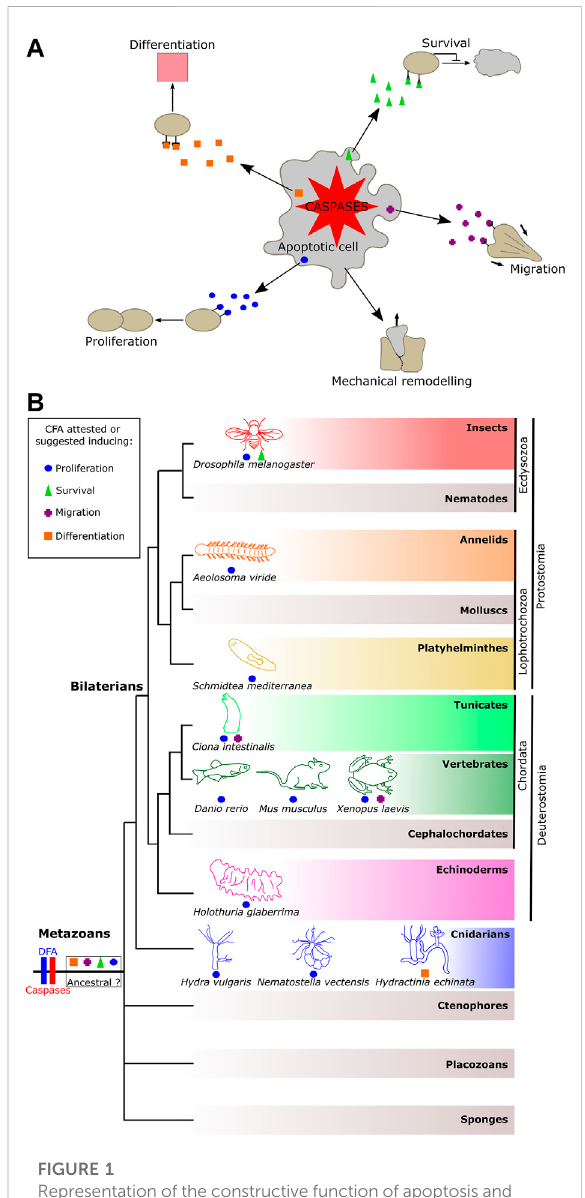
FIGURE 1 Representation of the constructive function of apoptosis and its occurrence among metazoans. (A) Constructive function of apoptosis(CFA)allowsapoptoticcellstopromotecellremodeling, fates, and behaviors to their neighbor in a caspase- dependent manner. (B) Distribution of the CFA among metazoan phyla. The CFA is quite widely distributed, suggesting two possible scenarios: a shared and ancestral origin among animals or conversely several convergent